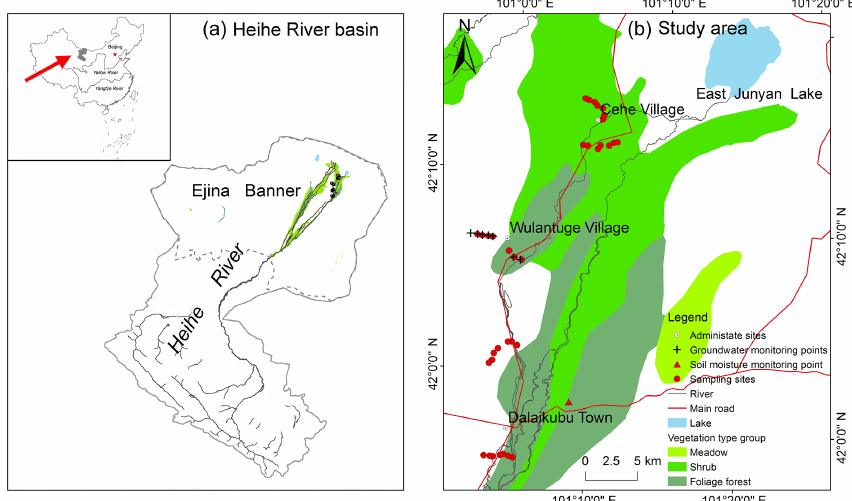
Figure 1. The Heihe River basin in China (a) and the location of sampling points in the study area (b)